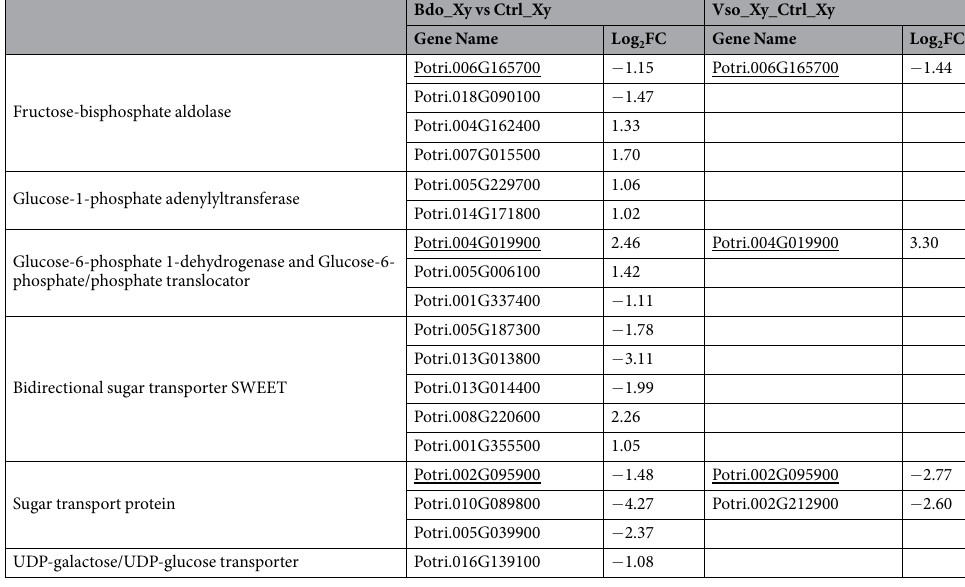
Table 3. DEGs related to starch and sucrose metabolism in poplar xylem tissues infected with canker pathogens. Notation: The gene ID with the underline represents the gene co-expressed in Bdo_Xy and